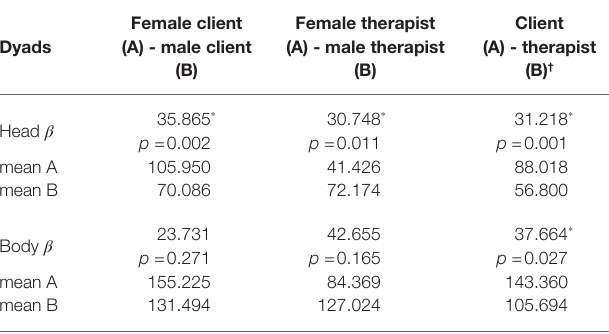
TABLE 2 | The mean differences between the individual movement between